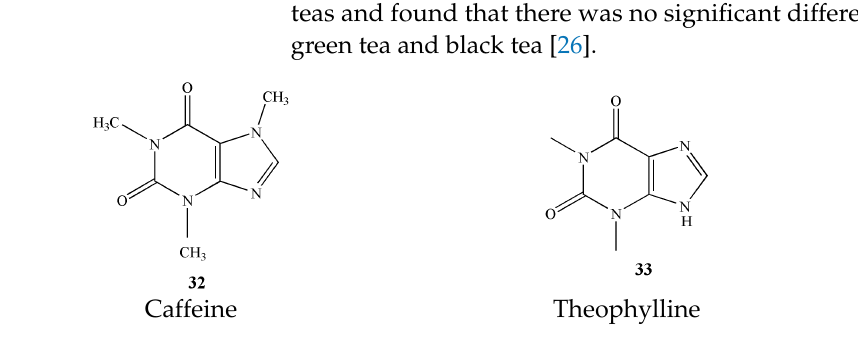
Figure 5. Chemical structures of alkaloids isolated from green tea.